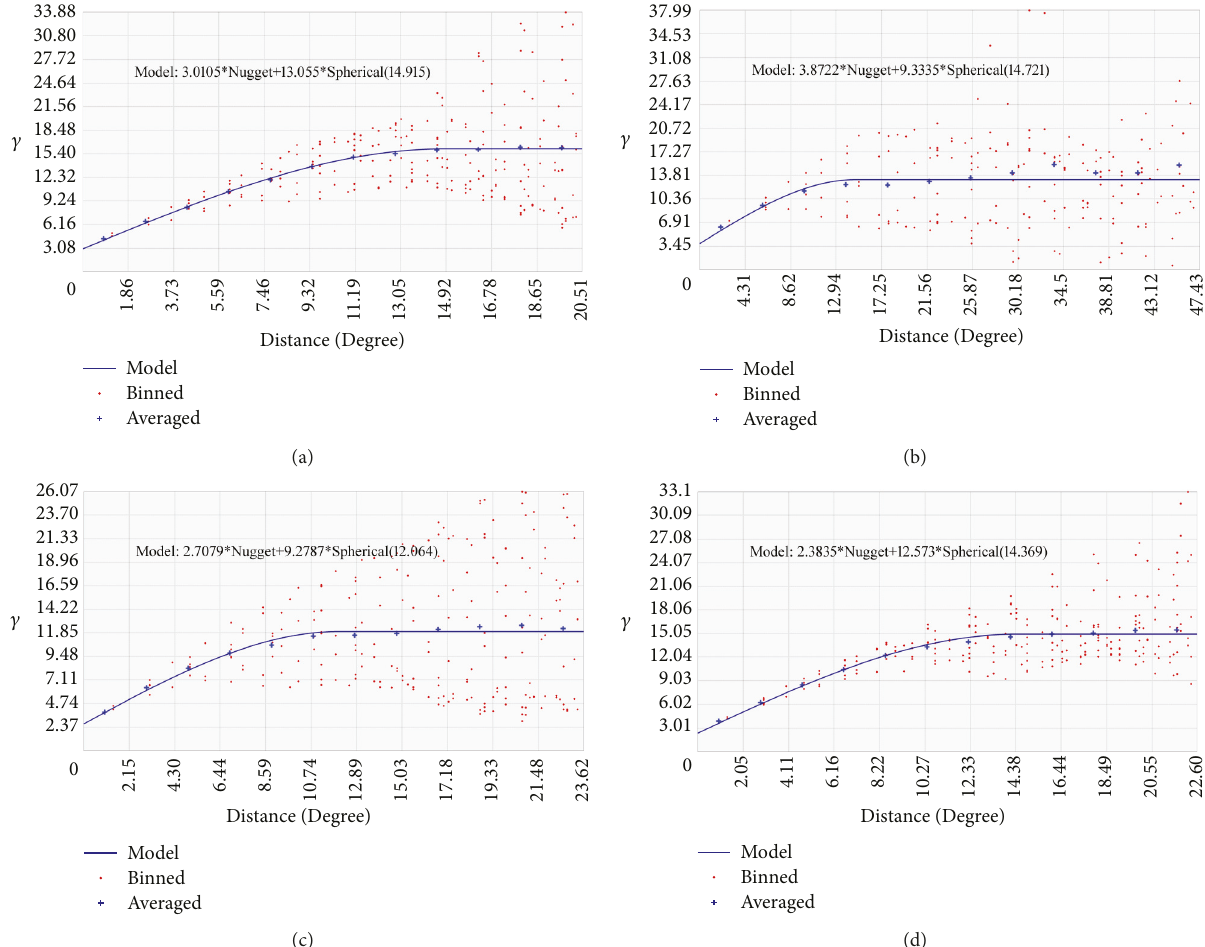
Figure 4: Observation binning and experimental semivariograms, and the fitted semivariogram models of residuals after detrending for (a) VE, (b) SS, (c) AE, and (d) WS. c (Distance) is the semivariogram function, where Distance is the distance of pairs of locations and Nugget is called the